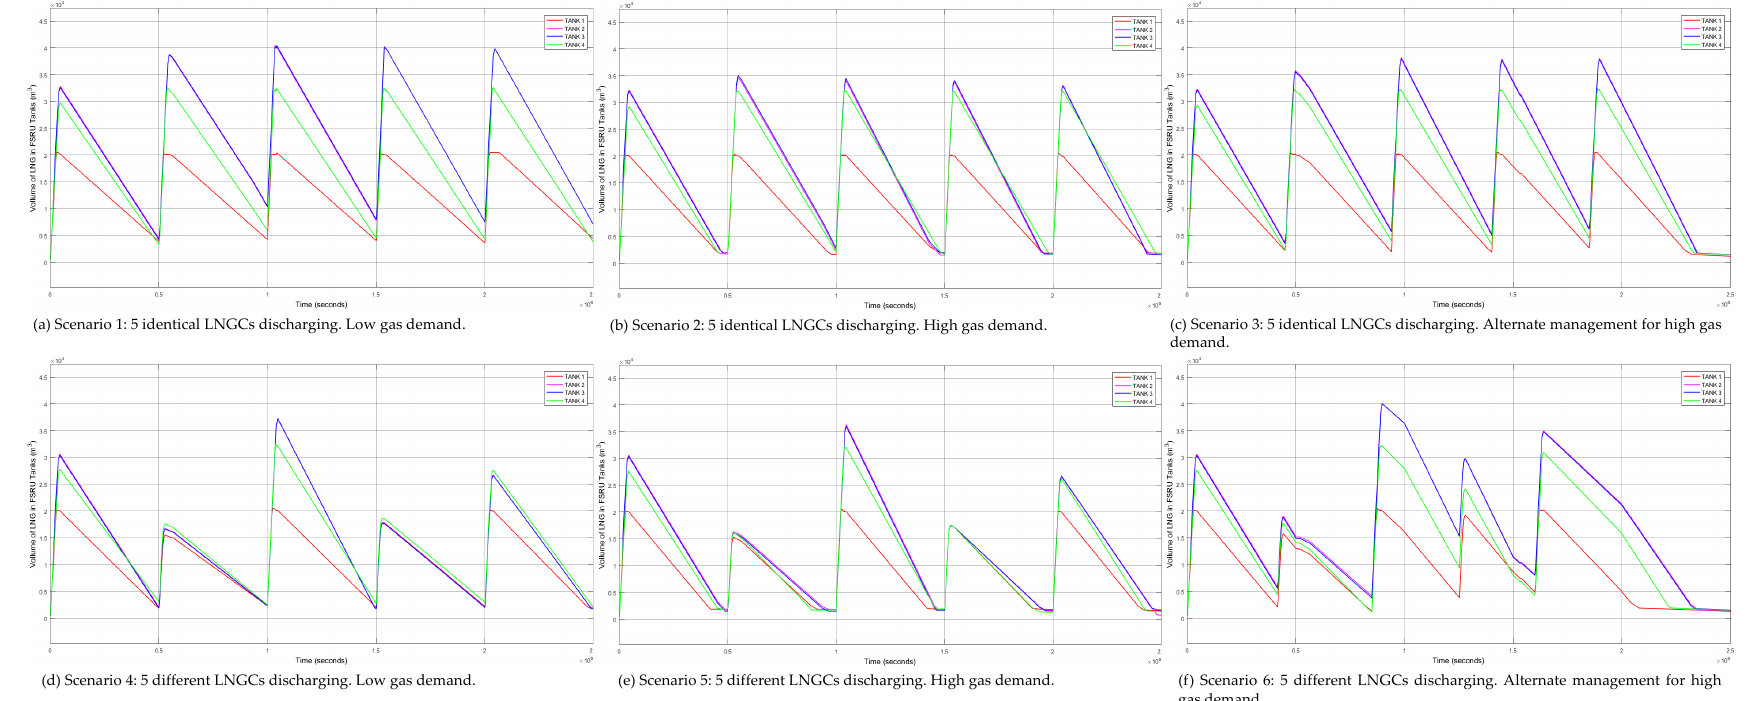
Figure 8. LNG stored in each cargo tank of the FSRUs for di ff erent operation